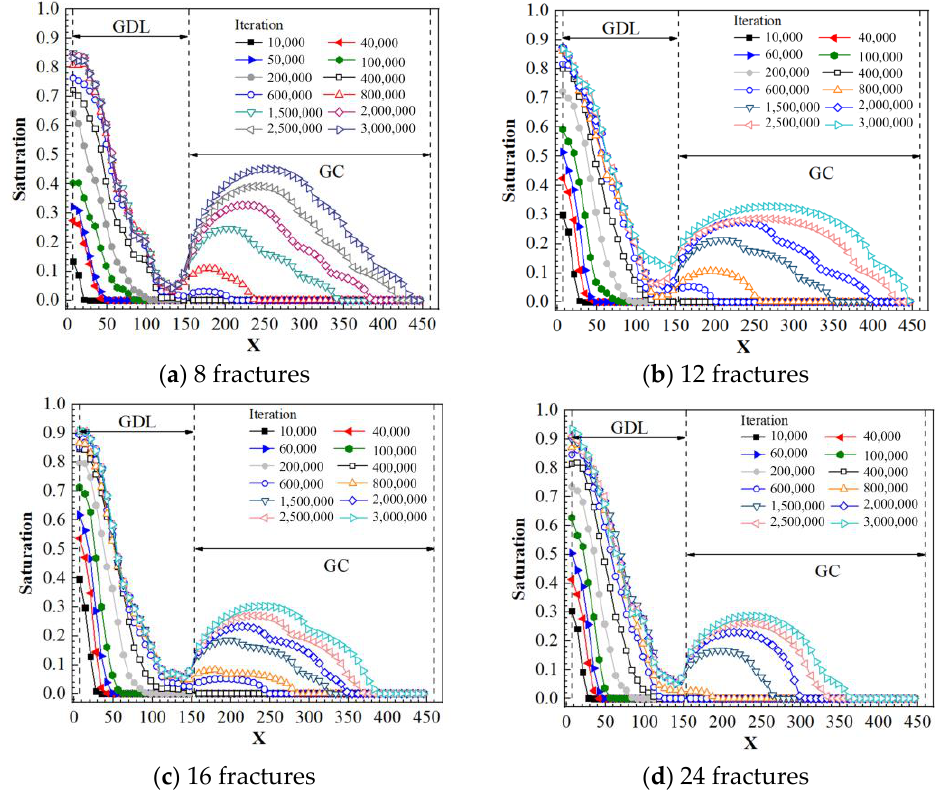
Figure 12. Through-plane liquid water saturation distribution in the domain with different fractures.